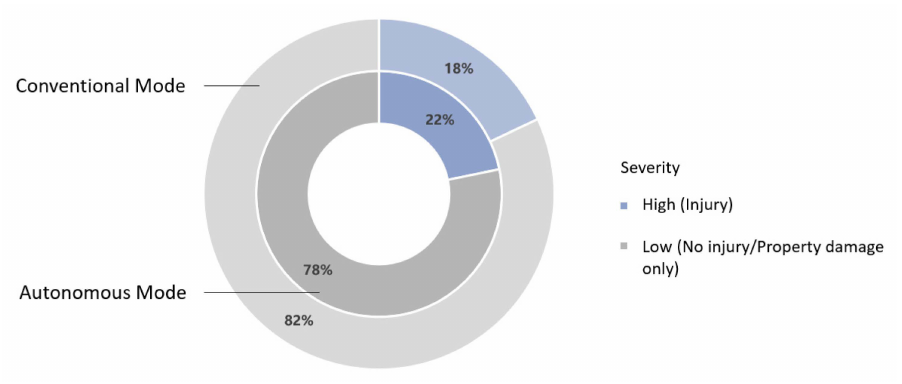
Figure 2. Statistical results of crash severity in both driving modes.